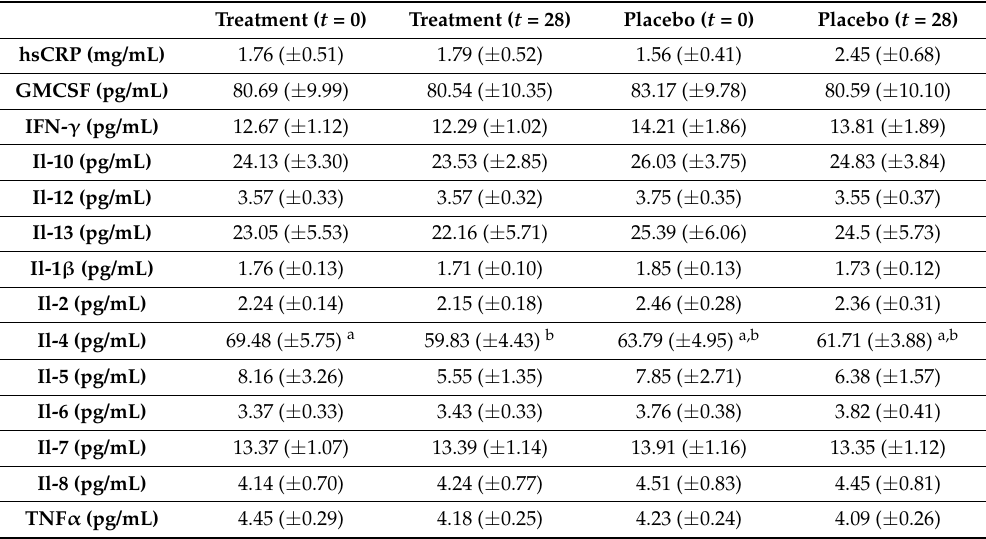
Table 2. Plasma C-reactive protein (CRP) and